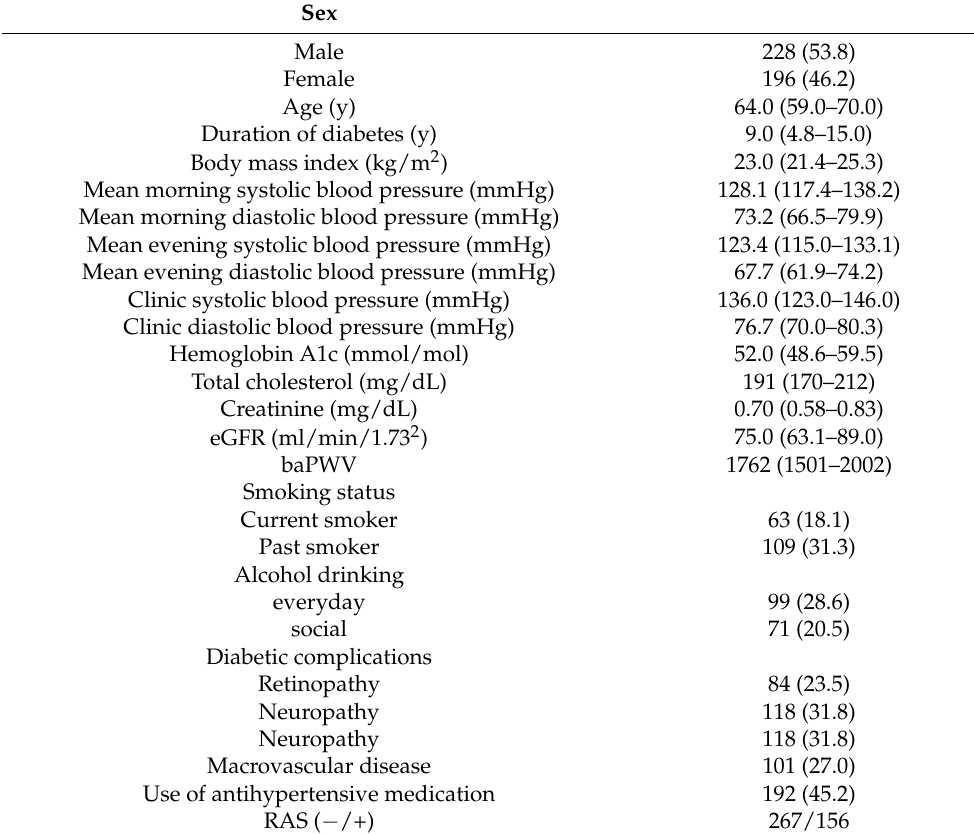
Table 1. Characteristics of patients.